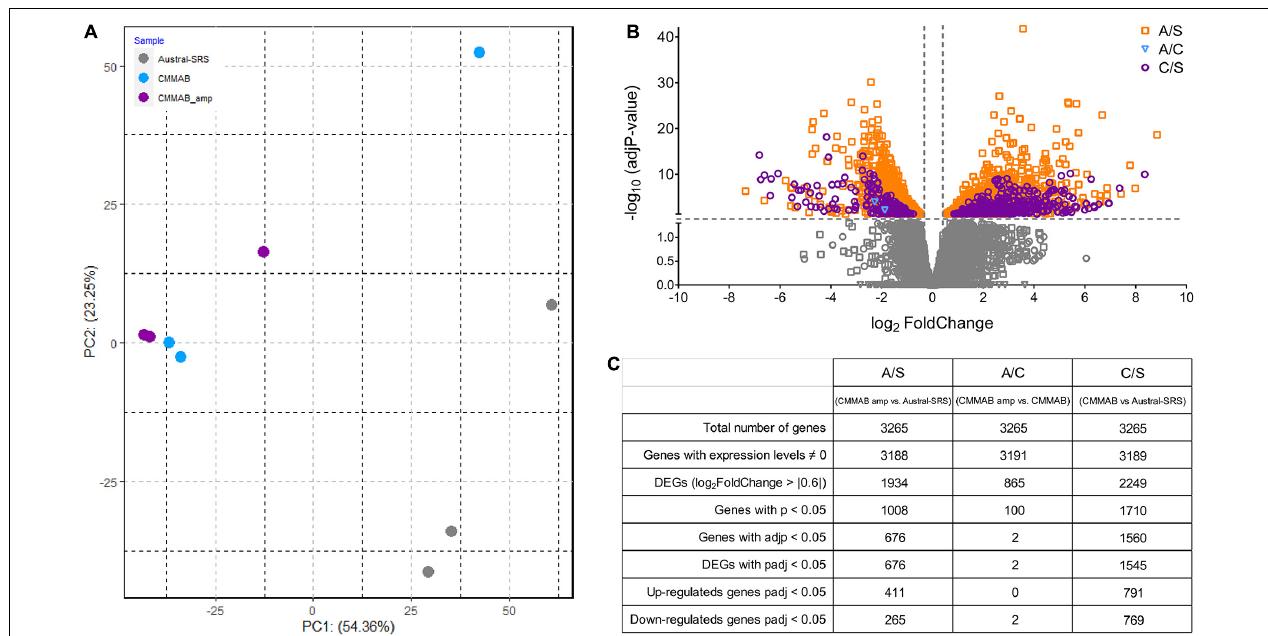
FIGURE 7 | RNA sequence data for P. salmonis LF-89. (A) Principal component analysis (PCA) plot of gene expression profiles of bacteria grown in Austral-SRS, CMMAB, or CMMAB with amp. (B) Gene transcripts identified in the following comparisons: bacteria grown in CMMAB with amp vs. Austral-SRS (A/S, squares); bacteria grown in CMMAB with amp vs. CMMAB (A/C, inverted triangles); and bacteria grown in CMMAB vs. Austral-SRS (C/S, circles). Data between and below the dotted lines (marked in gray) were not statistically significant (adjusted p -value > 0.05, log 2 fold change < | 0.6|). (C) Table showing a summary of the number of genes identified after RNA sequencing and data